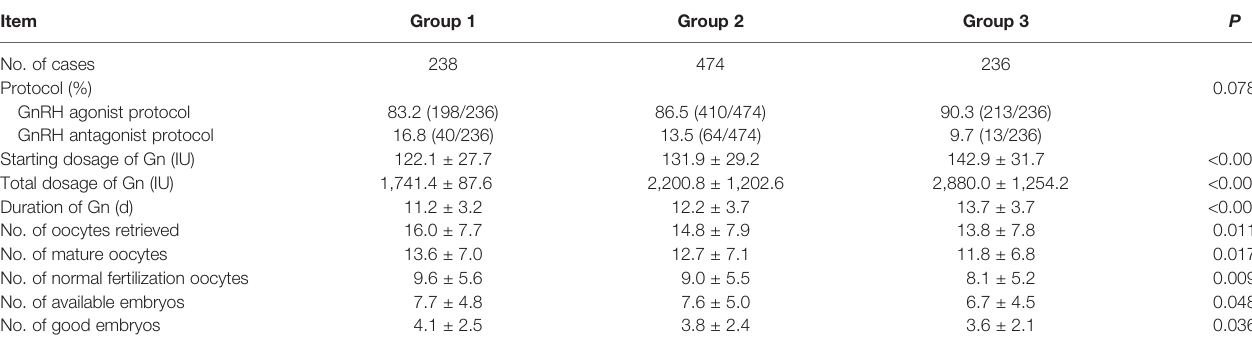
TABLE 2 | Ovarian stimulation characteristics among the three groups.